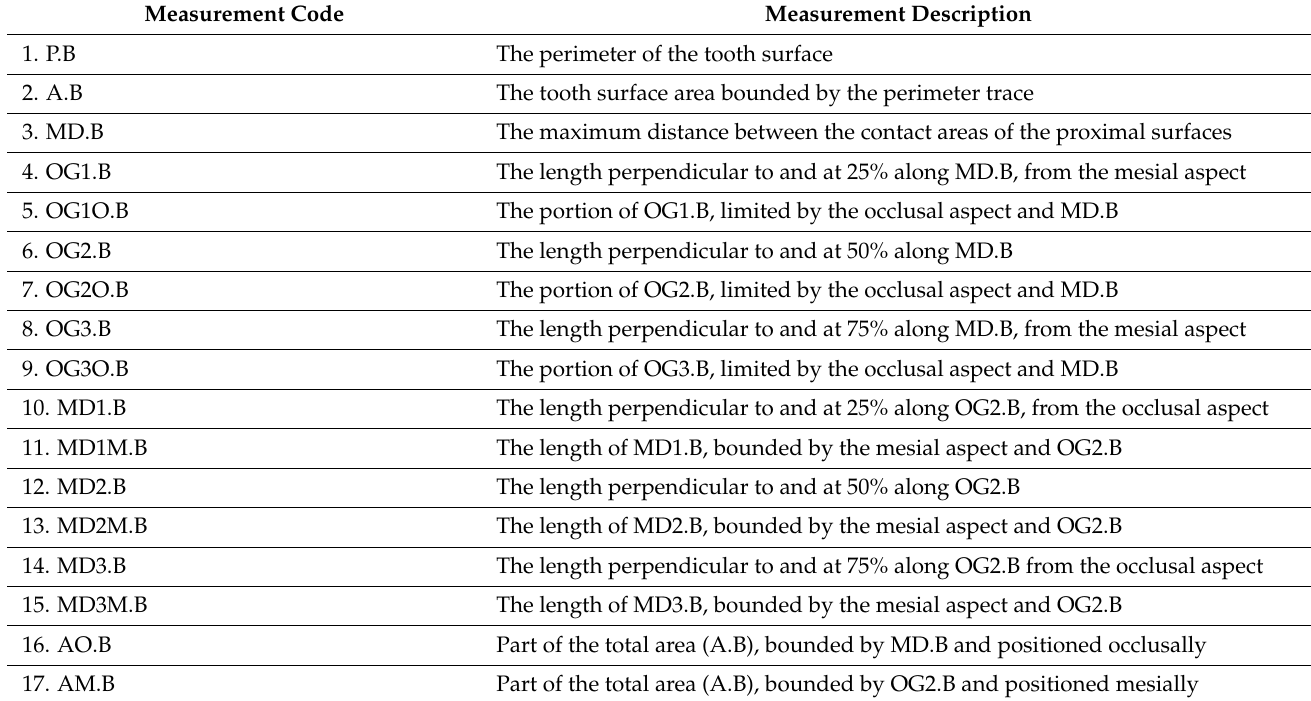
Table 1. Variables measured from the buccal view of each